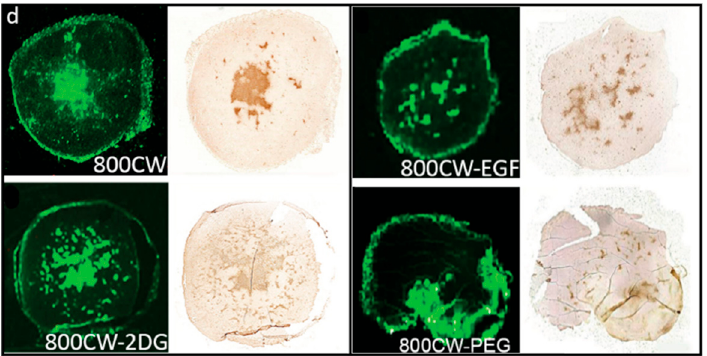
Figure 9. Imaging tumor necrosis with IRDye800 CW and its conjugates (2DG—2-deoxyglucose, EGF—endothelial growth factor, PEG—polyethylene glycol). IRDye 800 CW and its conjugates except